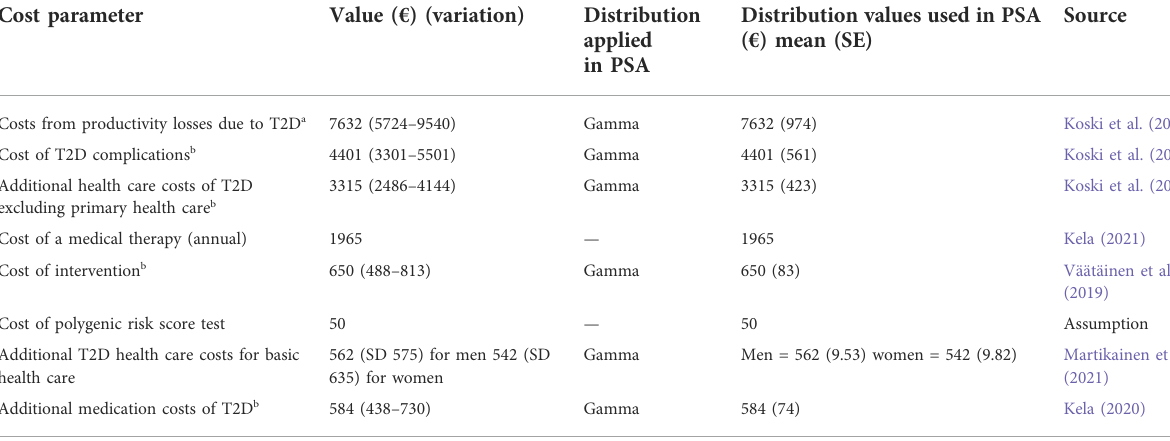
TABLE 2 Cost estimates and their distributions applied in the model.